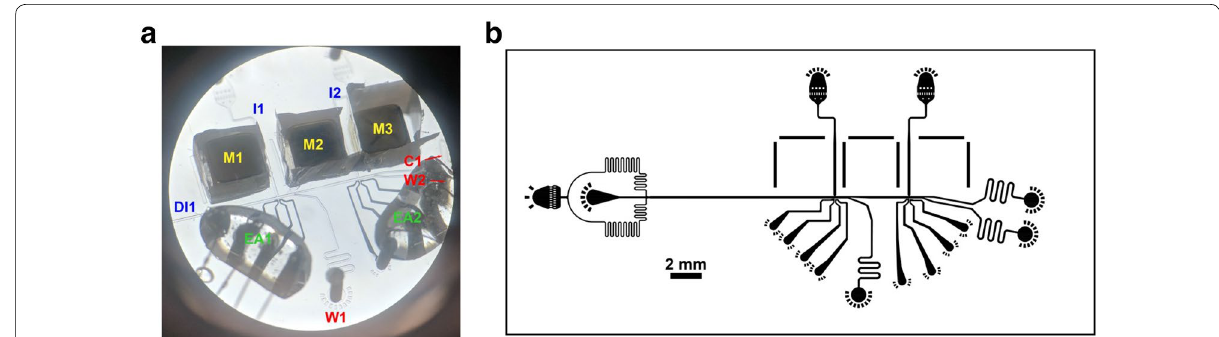
Fig. 2 Microfluidic device and schematic. a Microscope view of the microfluidic chip. The input channels are marked in blue (Droplet Input 1 – DI1, Injection 1—I1, and Injection 2—I2) and the outlet channels are marked in red (Waste 1—W1, Waste 2—W2, and Collection 1—C1). Three N52 magnets (M1, M2, M3) are labeled in yellow. The electrode arrays are labeled in green (EA1, EA2). b Microfluidic photolithography mask design for the two-stage washing